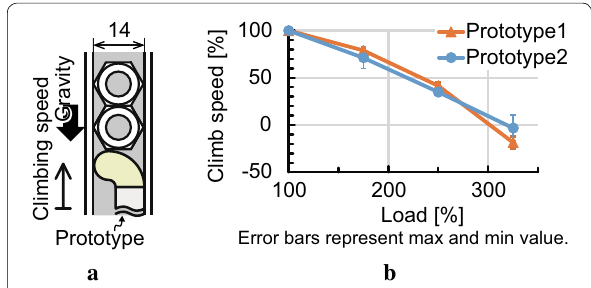
Fig. 14 Measurement of traction forces with both prototypes. a , b The experimental setup and measured results, respectively. The load values and speeds are obtained by 100 (cid:31) 1 + N · m N / m p (cid:30) [ % ] and 100 ( v / v 0 ) [ % ] , respectively, where m p and m N denote the weight of the prototype and M8 nut, respectively, N is the number of nuts, and v and v 0 denote the climbing speed with nuts and without nut